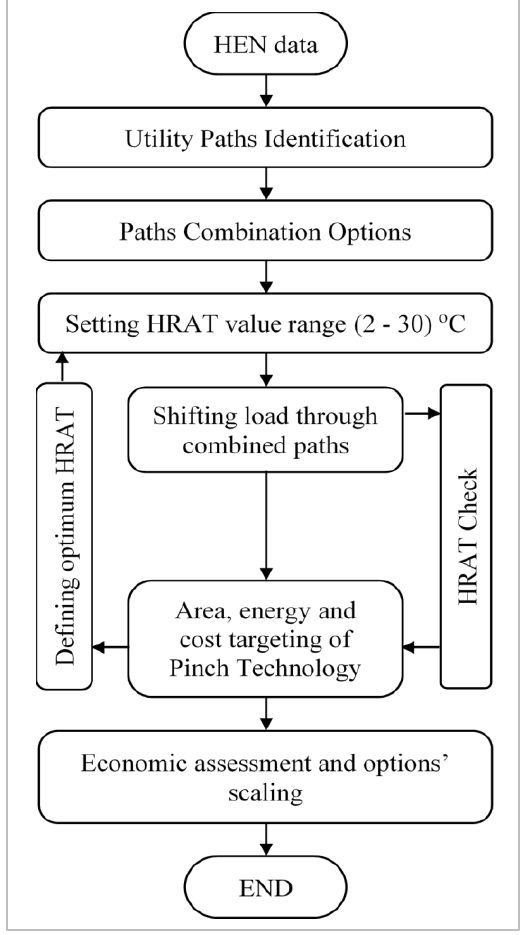
Figure 2. Method flow